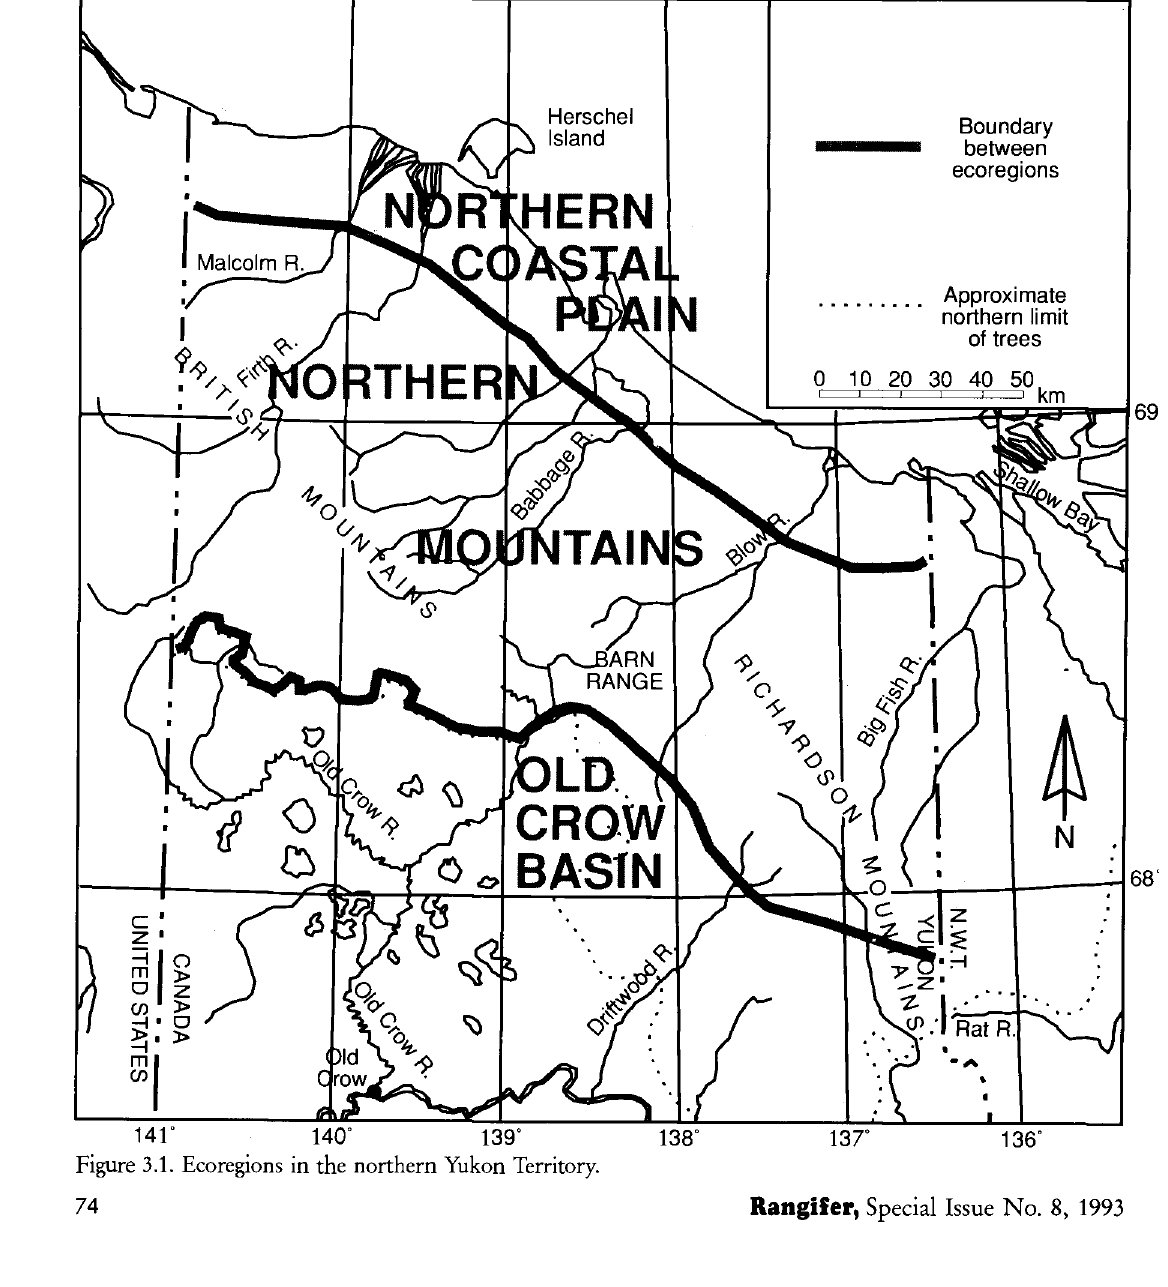
Figure 3.1. Ecoregions in the northern Yukon